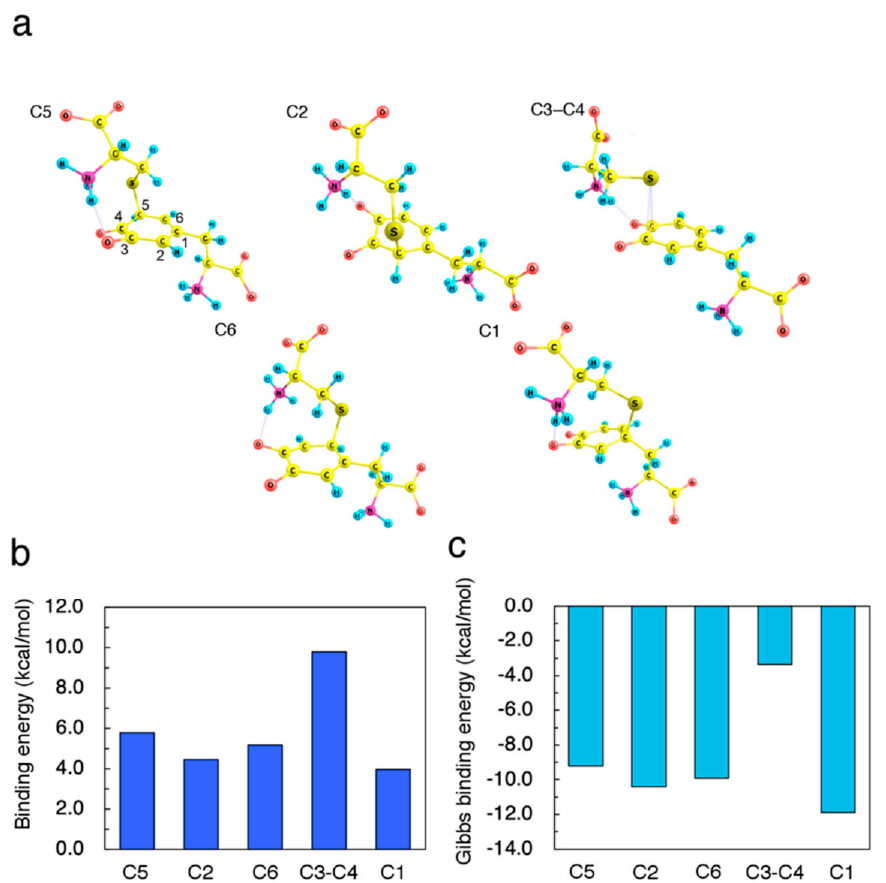
Figure 2. Properties of Cys–S − -attacked dopaquinone (DQ) intermediates. ( a ) Optimized ge- ometries resulting from (C5) 5-addition, (C2) 2-addition, (C6) 6-addition, (C3–C4) bound on 3,4-bridge, and (C1) 1-addition. ( b ) Binding energies E b of Cys–S − on DQ, which are defined as E b = ( E Cys–S − + E DQ ) − E Cys–S − –DQ , where E Cys–S − , E DQ , and E Cys–S − –DQ are the total energy of Cys–S − , DQ, and Cys–S − -attacked DQ, respectively. ( c ) Gibbs binding energies of Cys–S − on DQ computed based on the vibrational analysis at 37.0 ◦